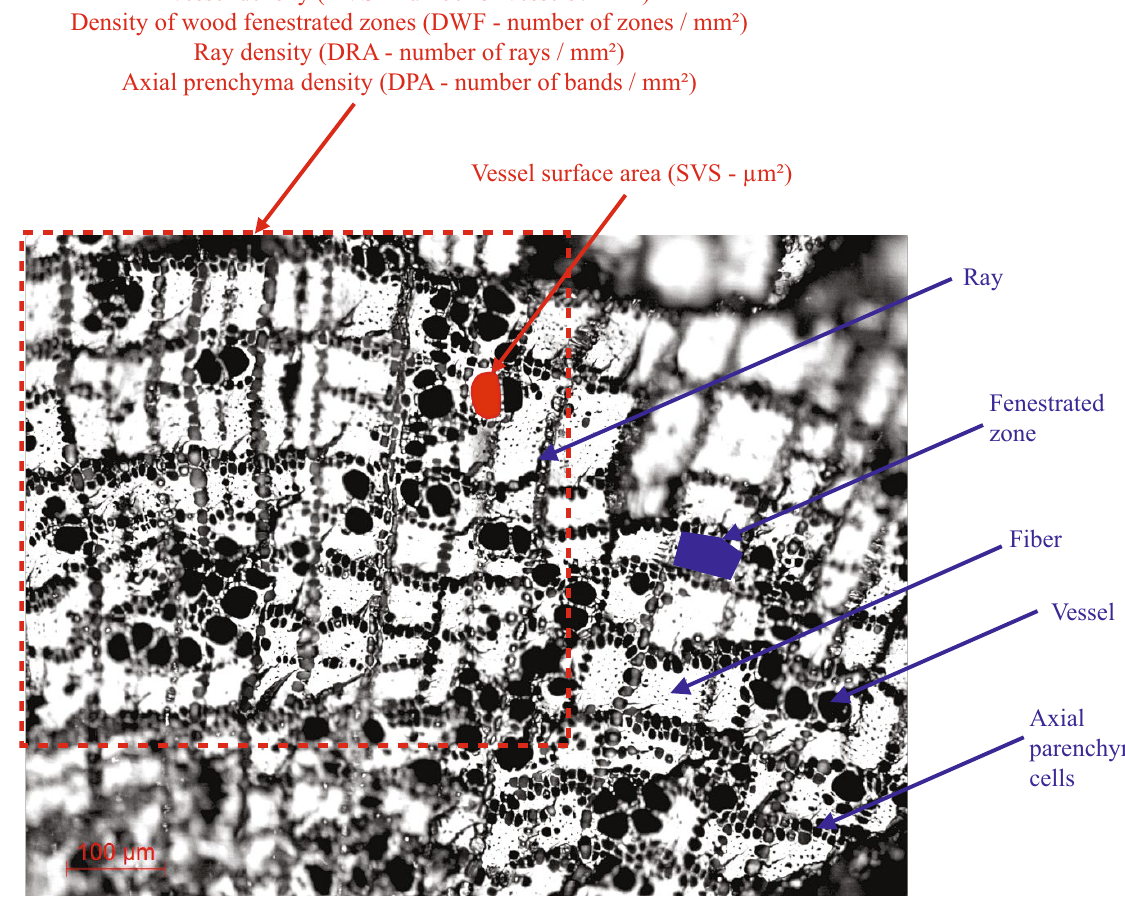
Figure 6. Wood anatomical features of the Argan tree (in blue) and measured anatomical characters (in